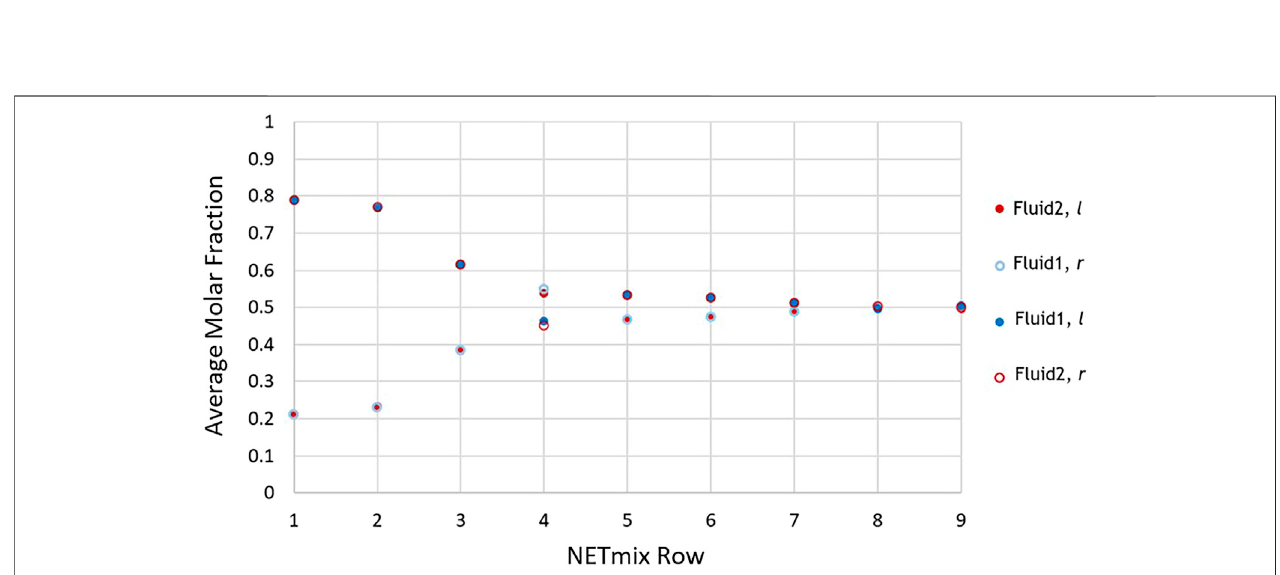
TABLE 1 | Comparison between BLMS and Tracer in chamber C6